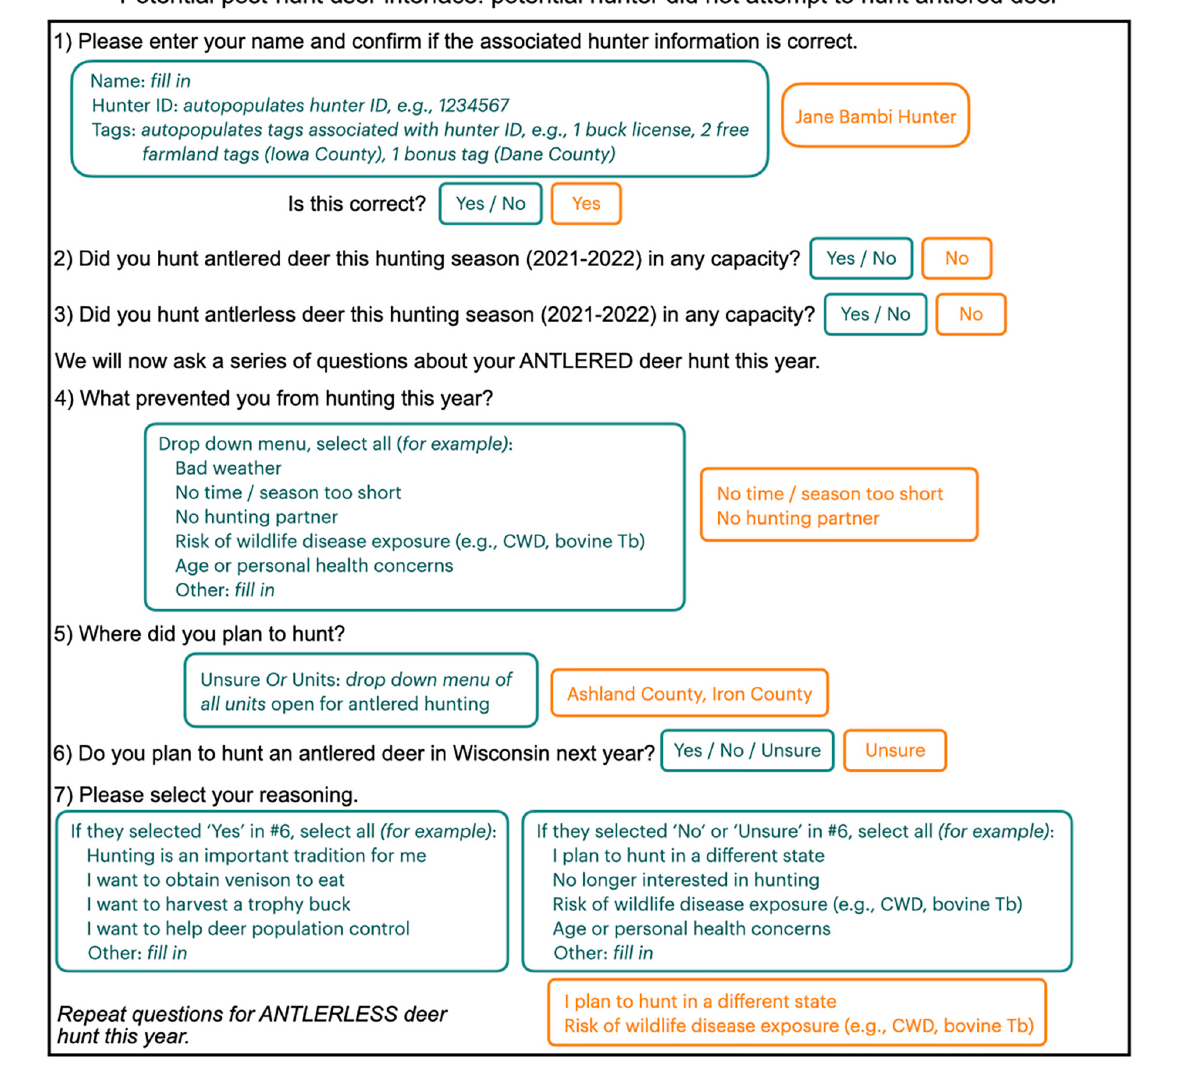
FIGURE6 Example post-hunt user interface, such as a website or smartphone application, that collects metadata necessary to link individual tag holders to their unattempted harvests, and links the reasoning for the unattempted harvests to the appropriate spatial scales of deer tag issuance and filling. This is an example of a hypothetical Wisconsin tag holder (“potential hunter”)—i.e., a state where antlered deer are managed under a bag structure and antlerless deer are managed under either a bag structure (free farmland tags) or a quota structure (bonus tags). Black text shows agency designed prompts; teal text shows user interface options where plain text denotes options or titles and italics denotes design choices; orange text shows hypothetical hunter selections or responses. The appearance and order of questions can be dependent on the previous responses such that questions that are not relevant to the hunter or situation do not